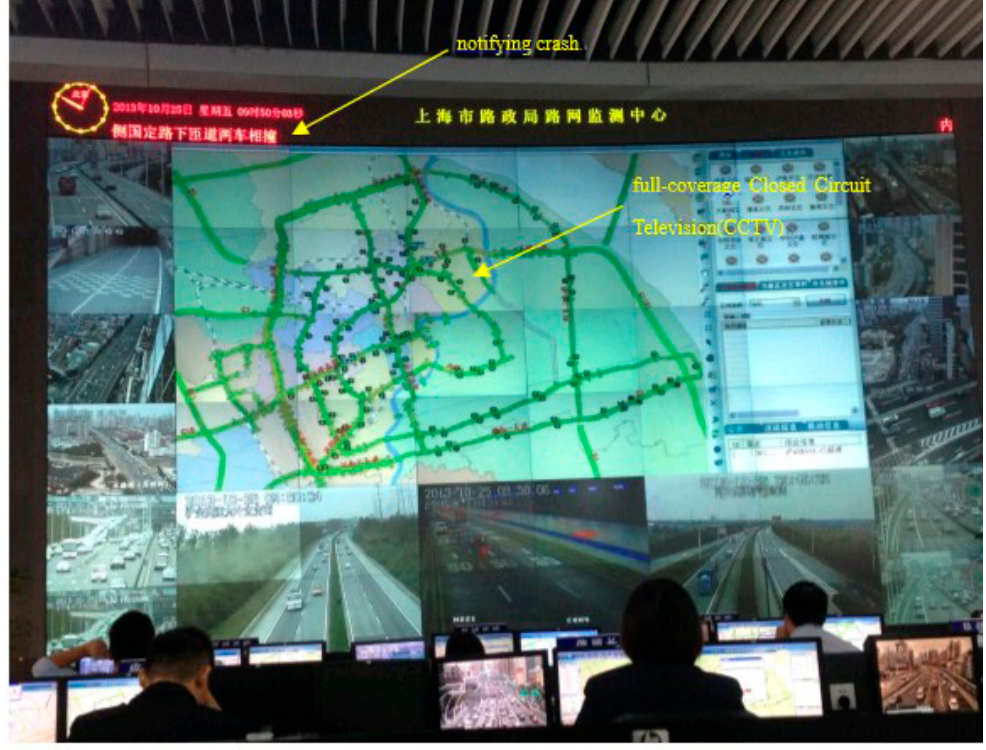
Figure 1. The surveillance center of